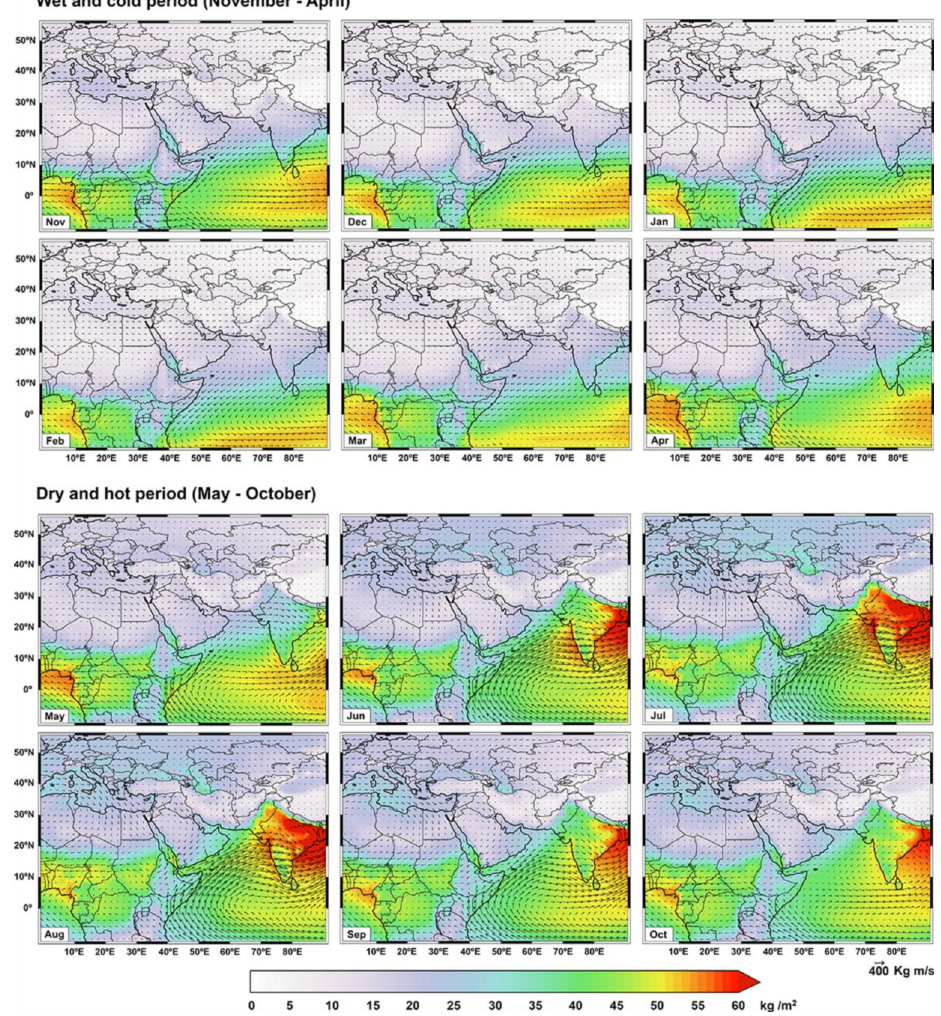
Figure 2. The northward and eastward data of the vertically integrated moisture flux (VIMF) with a 1° × 1° resolution from 1981 to 2021 are derived from ERA-Interim reanalysis [53]. 1 ◦ × 1 ◦ resolution from 1981 to 2021 are derived from ERA-Interim reanalysis